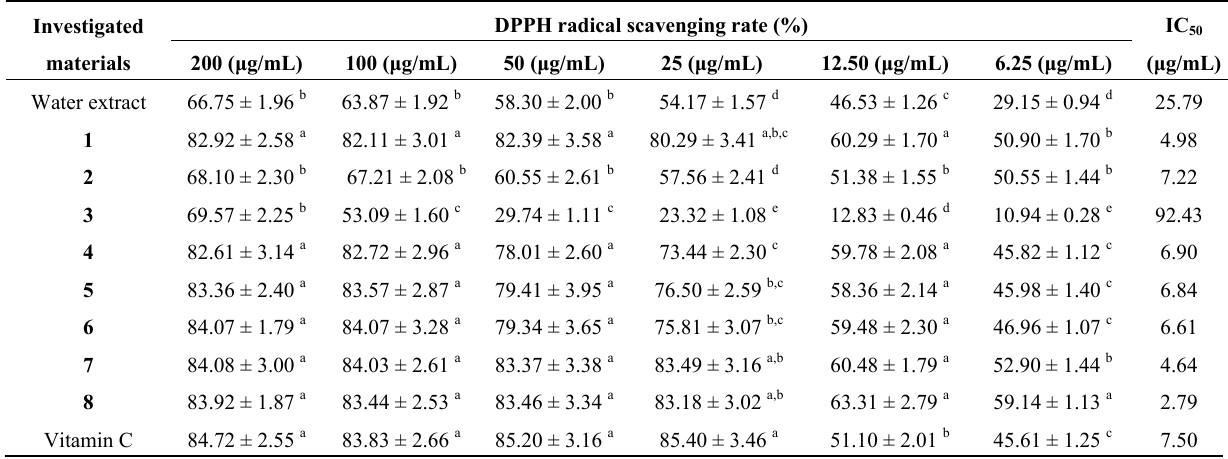
Table 1. DPPH radical scavenging rate.